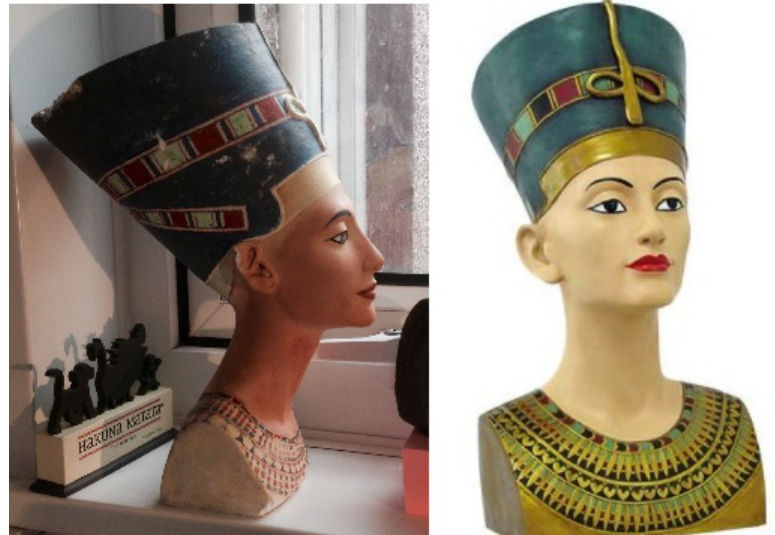
Figure 7: Comparison of open source version (left) and the commercial version (right) of the Nefertiti life size model (Horne, 2021; Amazon,